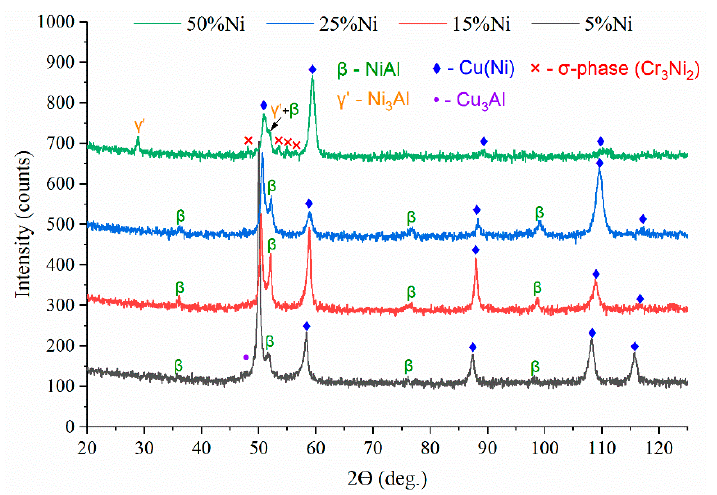
Figure 2. X-Ray diffraction patterns of bronze/Inconel multimaterial samples produced with 5%Ni, 15%Ni, 25%Ni, and 50%Ni.